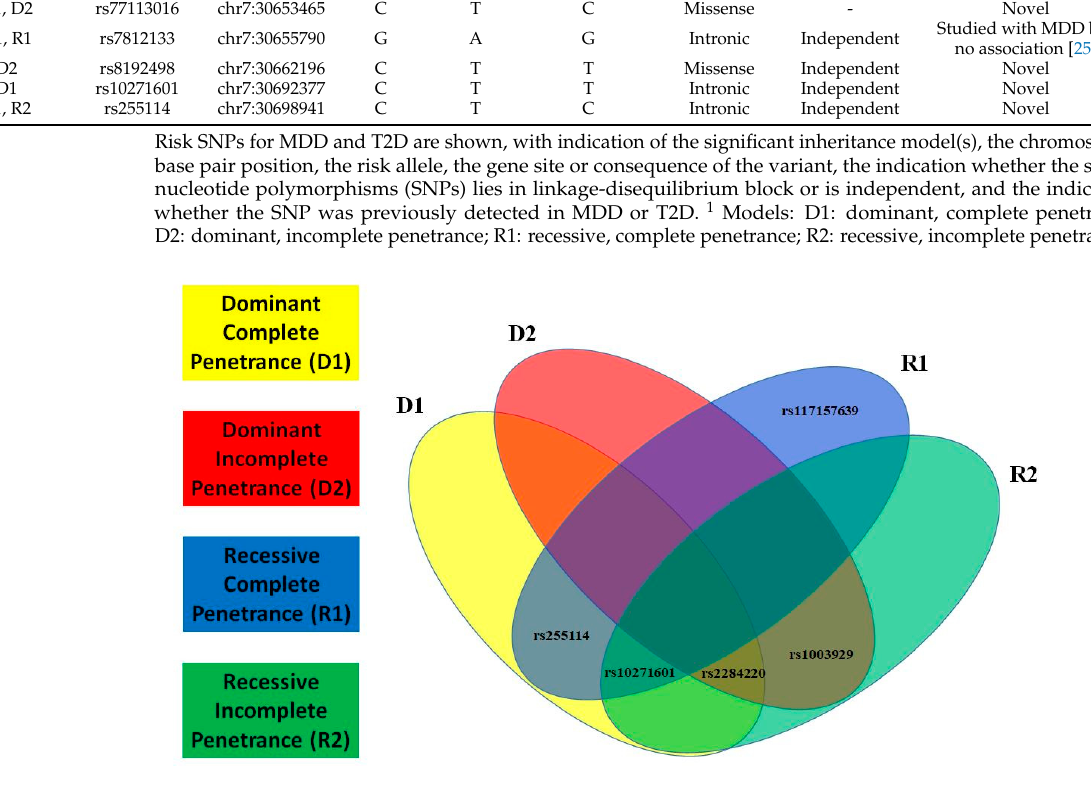
Figure 3. Major Depressive Disorder (MDD) Overlapping Risk Single Nucleotide Polymorphisms (SNPs). Overlapping models for CRHR2 -risk SNPs in MDD using a Venn diagram.